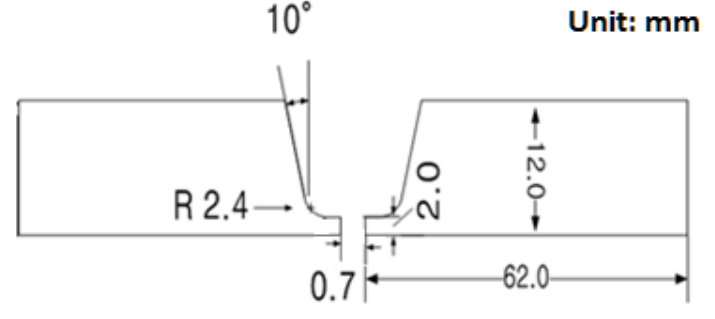
Figure 2. U-groove with narrow gap.